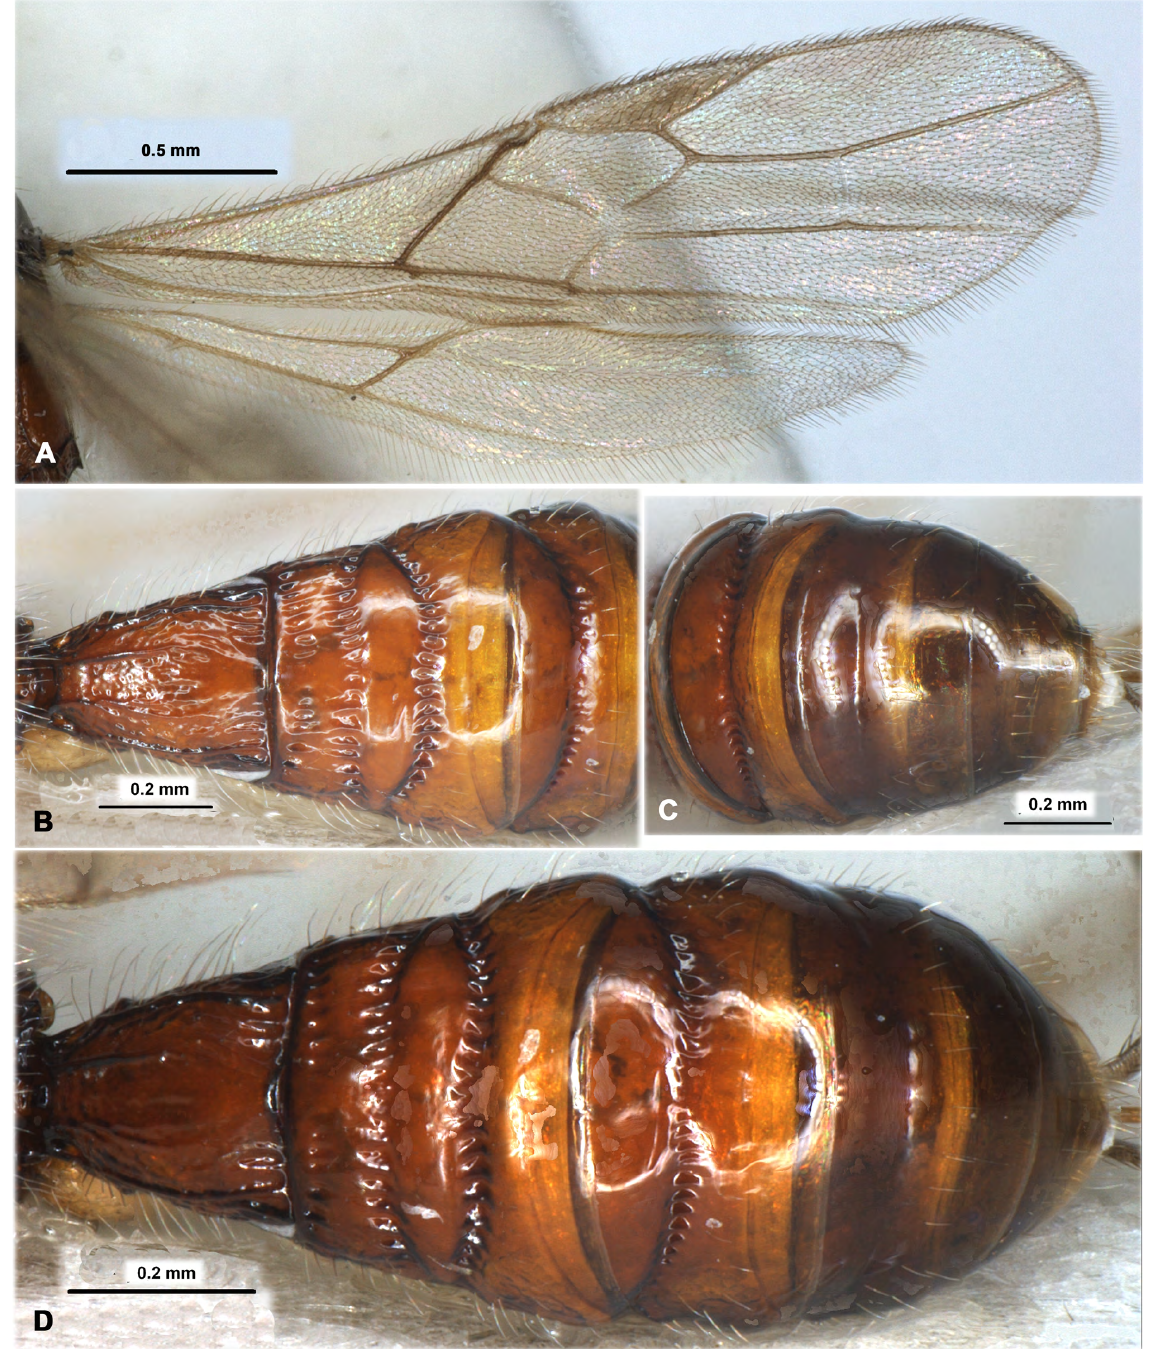
Fig. 19. Ipodoryctes ( Afroipodoryctes ) reunionus sp. nov., ♀, holotype, MNHM. A . Wings. B . First to third metasomal tergites, dorsal view. C . Apical metasomal tergites, dorsal view. D . Metasoma, dorsal